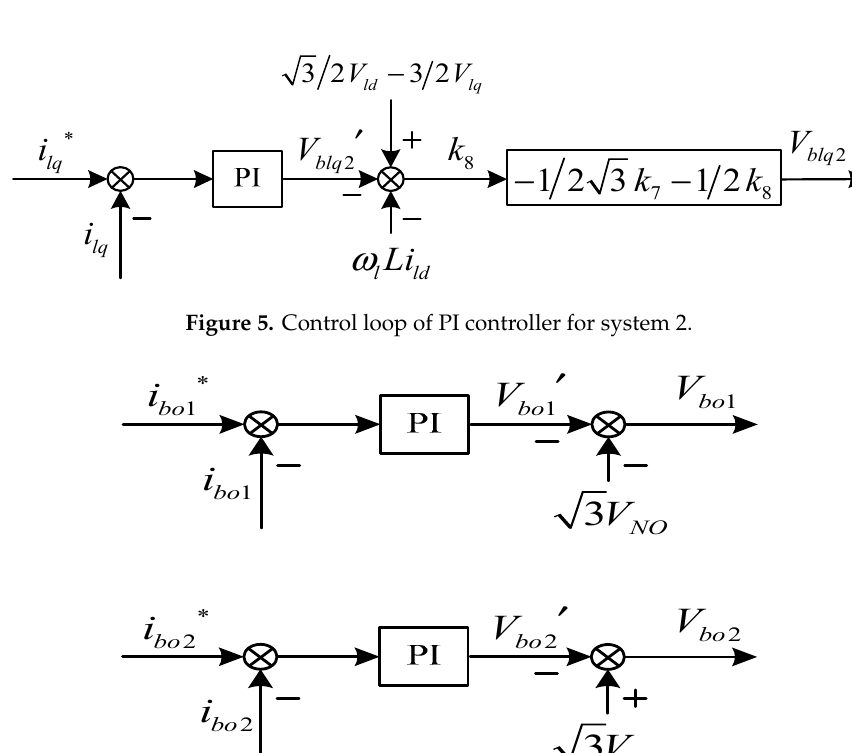
Figure 6. Current control loop of PI controller for zero sequence.